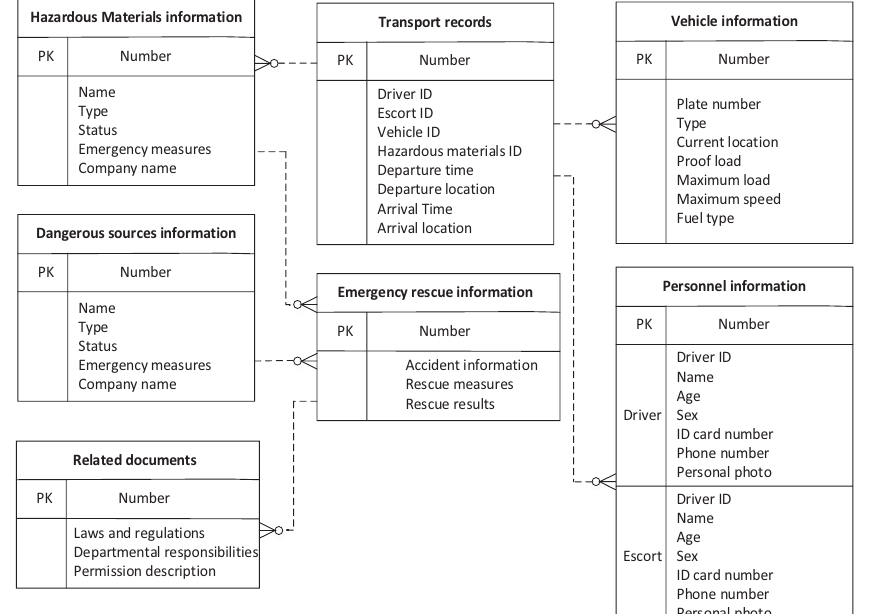
Figure 6 Data tables relation